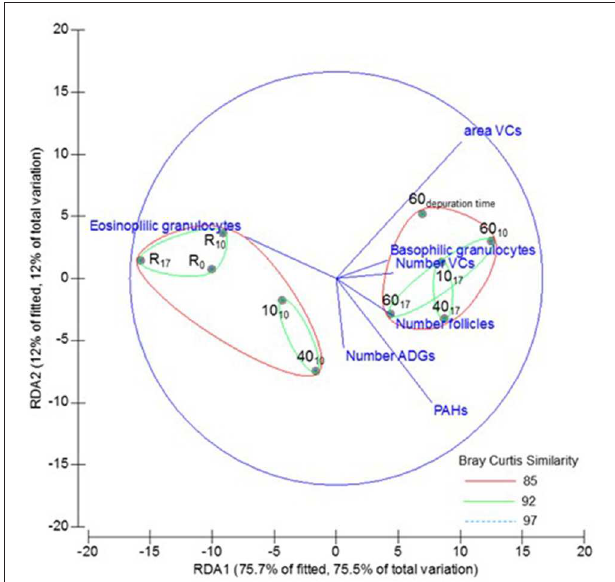
FIGURE 8 | Multivariate analysis: cluster analysis overlayed to dbRDA based to the fitted model selected by Bray-Curtis similarity of chemicals accumulation, and biometric and morphometric variables from Mytilus galloprovincialis , exposed to different tar concentrations during 0, 10, and 17 days (subscripts). R, Reference